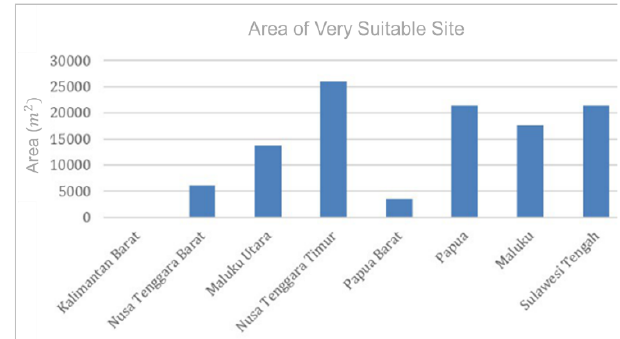
Figure 8 . PLTS Development Area with Very High Suitability